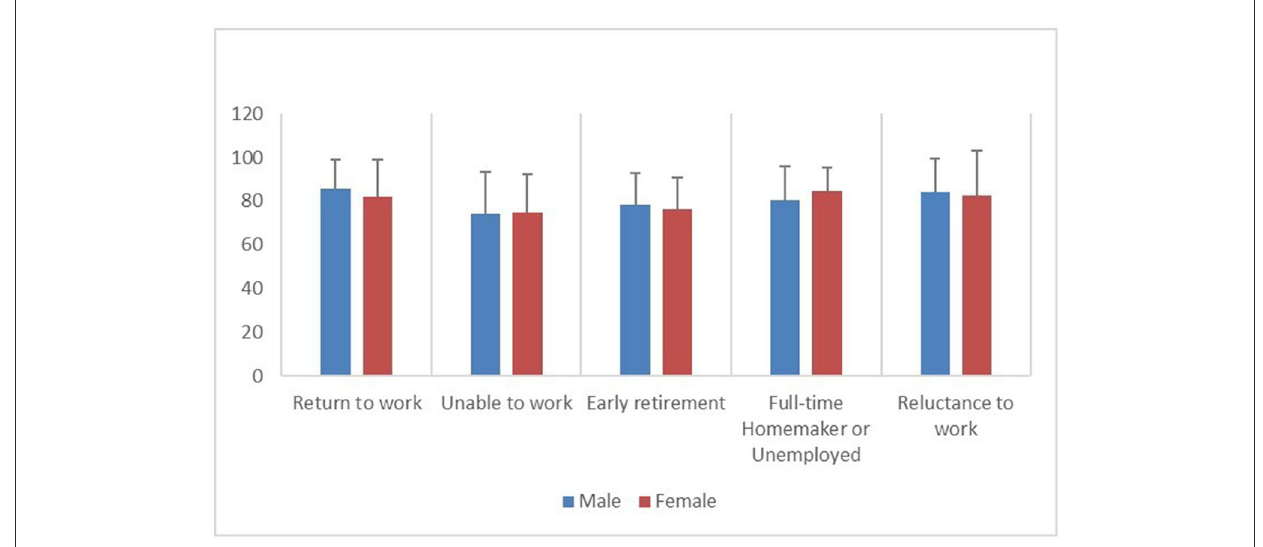
FIGURE5 Distribution of EQ-5D VAS among patients who have returned to work and the four groups of patients who have not returned to work, stratified by